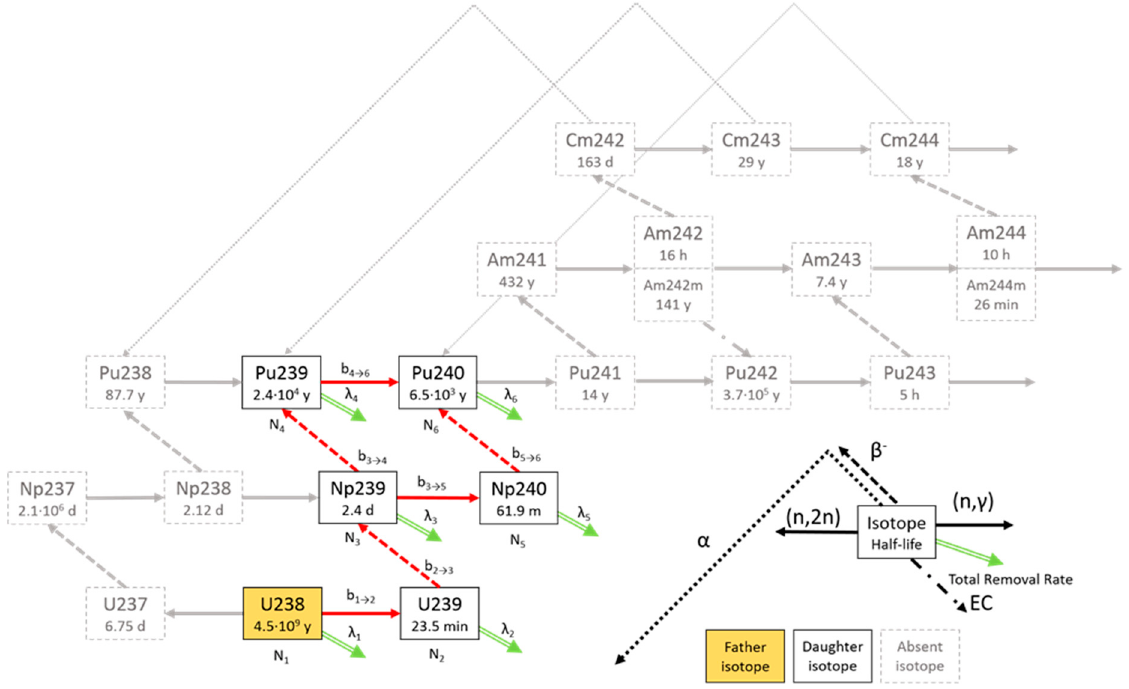
Figure 2. Burnup chain for the uranium cycle.